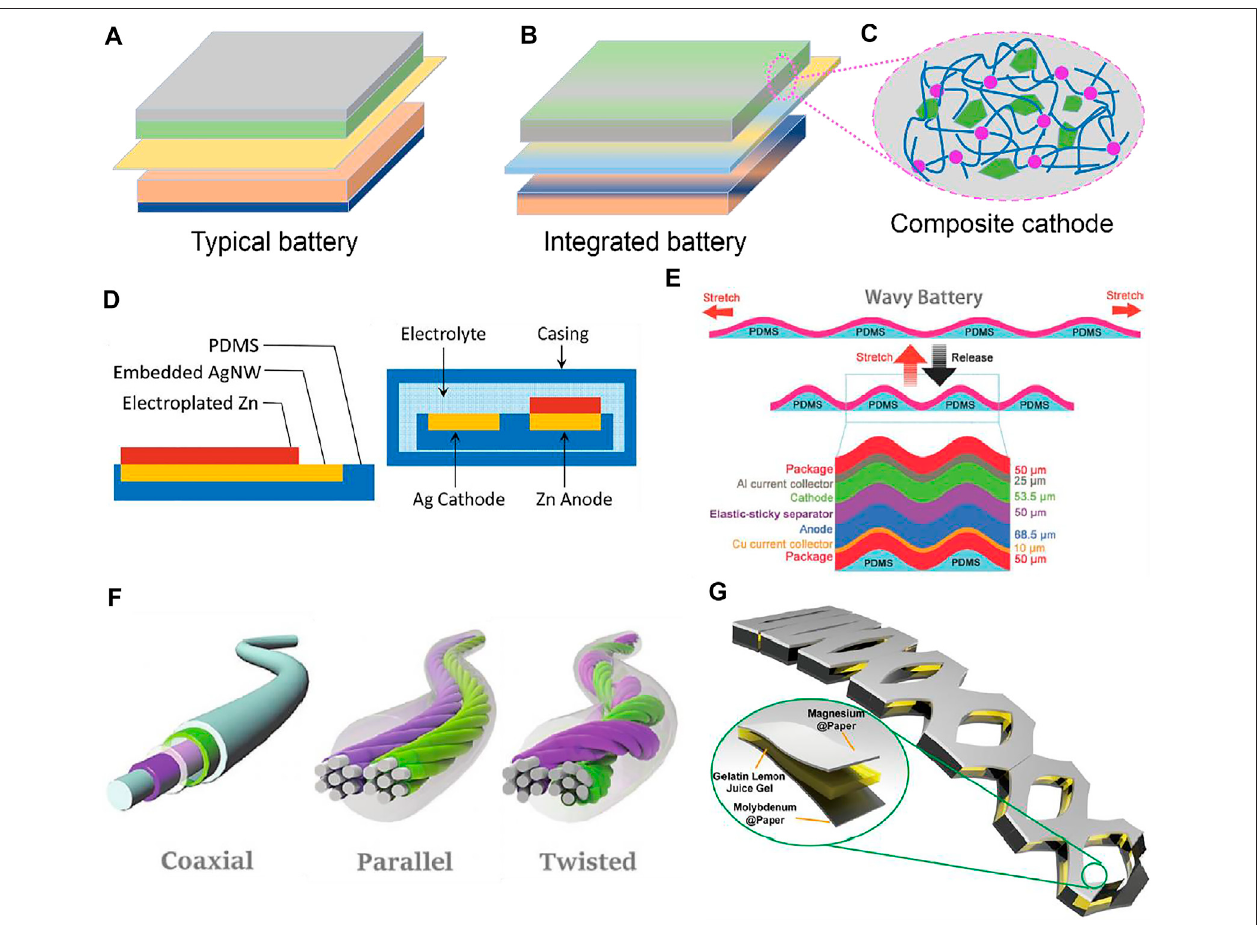
FIGURE 1 | Illustration of one cycle of typical battery con fi gurations with 5 stacked layers (A) and integrated battery con fi gurations with 3 stacked layers (B) by integrating the current collector with the electrochemical active materials. (C) Illustrations of the active materials embedded into stretchable polymer networks as a composite electrode. (D) Schematics of battery con fi gurations by embedding the current collector into stretchable PDMS (reproduced from Yan et al. (2014)). (E) The wavy battery structure based on the wavy stretchable PDMS substrate (reproduced from Mackanic et al. (2020a)). (F) Three types of fi ber-shaped batteries (reproduced from Mo et al. (2020)). (G) Three types of kirigami-modi fi ed batteries (reproduced from Wang et al. (2021)).